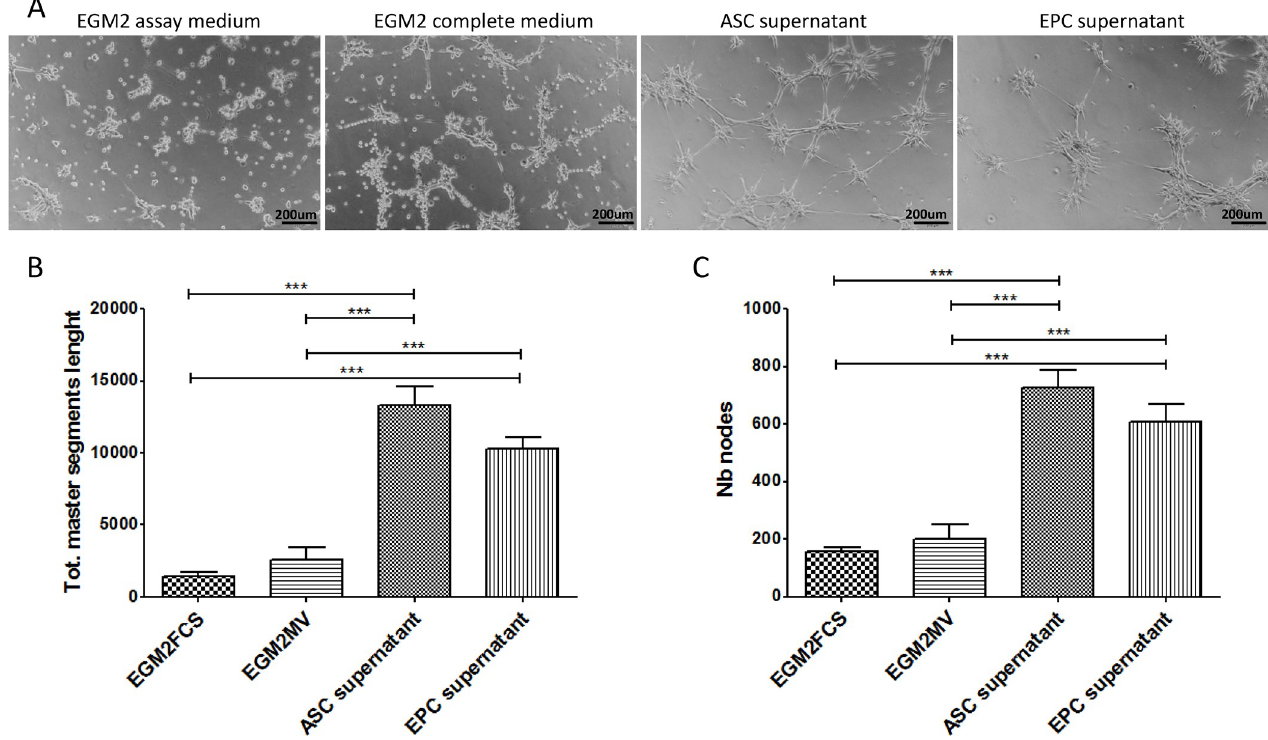
Fig 4. Supernatant from ASCs cultures promotes EPCs tube formation in vitro . (A) Representative images of EPCs tube formation on matrigel in the presence of supernatant from ASCs or EPCs cultured for 48 hours. Fresh EGM2 assay medium was used as a negative control, and complete EGM2 medium was used as a positive control. Higher-magnifications views are presented (B-C). Total master segment length (B) and number of branch nodes (C) were calculated from 6 random fields in images of three wells in series. Data are presented as mean ± SEM. ��� , p < 0.001.